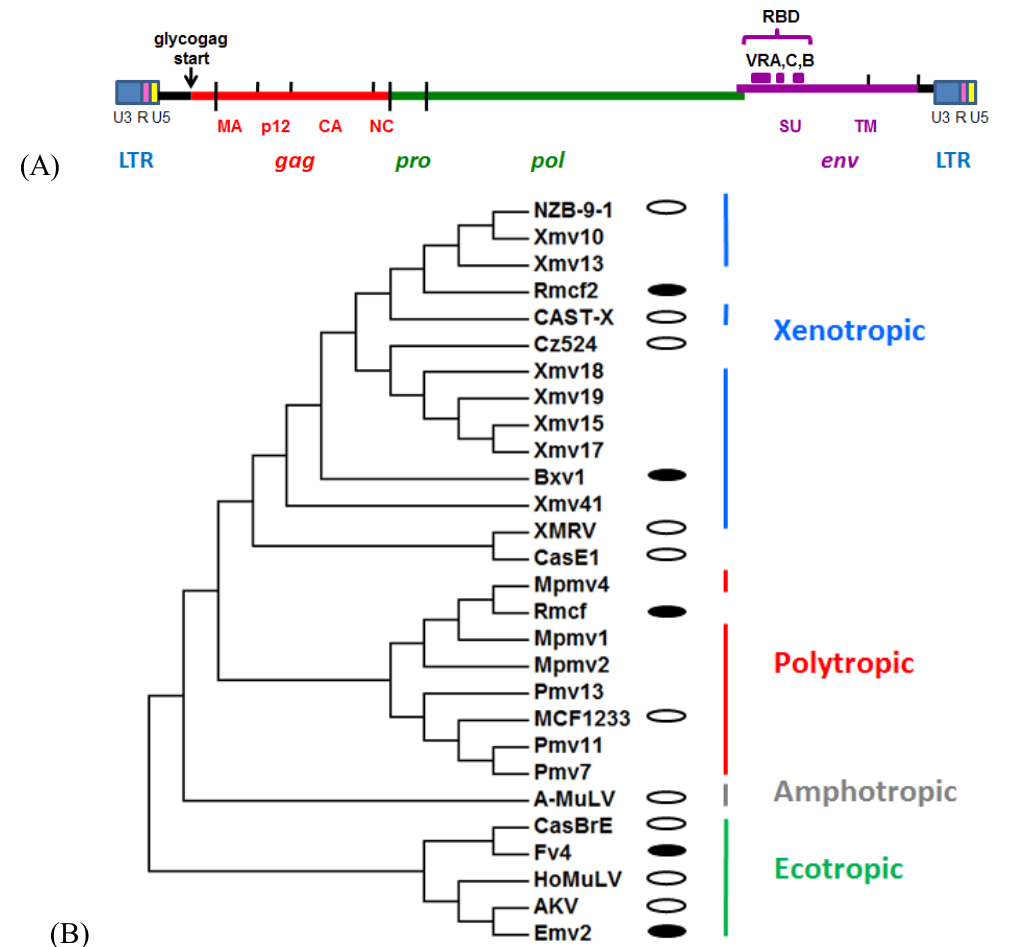
Figure 1. Endogenous and exogenous MuLVs. ( A ) Genomic structure of MuLV ERVs. ( B ) Phylogenetic tree of MuLV env receptor binding domains (RBDs) constructed using the neighbor-joining method [11] and inferred from 500 replicates using MEGA6 [12]. White ovals represent exogenous viruses; black ovals are active ERVs that produce viral proteins or infectious viruses; the rest are ERVs with unknown